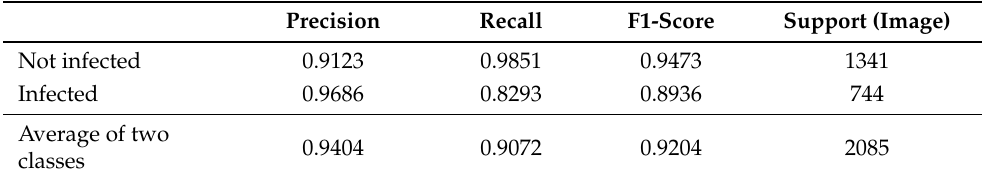
Table 9. Performance of the model in external dataset-1 for both